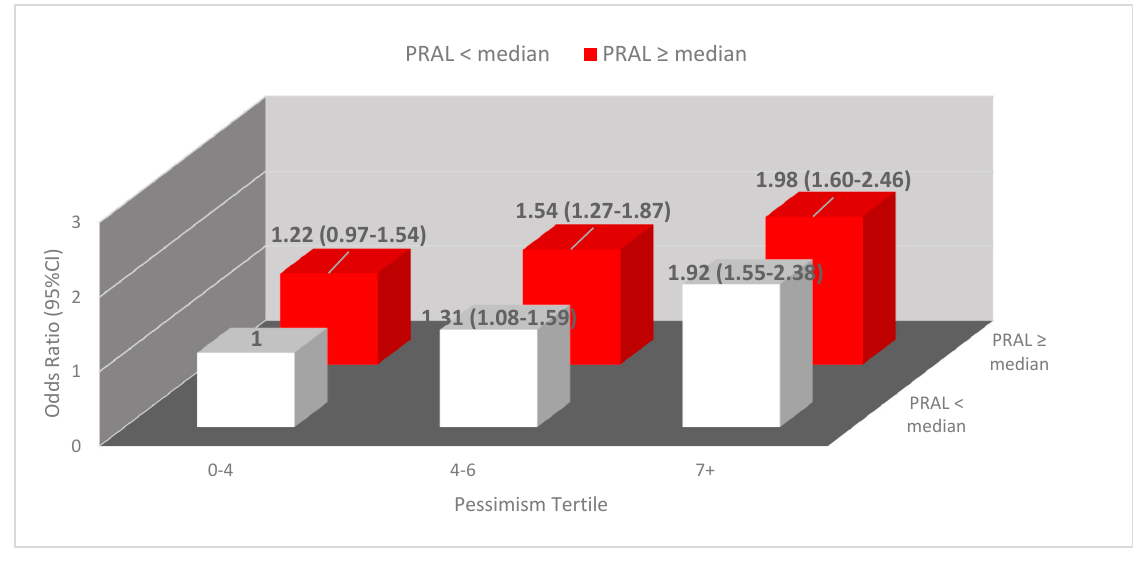
Figure 1. ( A ) Joint association of calorie intake and pessimism with insomnia. Covariates in the multivariable-adjusted model include caffeine quartile, BMI, age, smoking status, status of estrogen receptor and progesterone receptor, baseline co-morbidities, menopausal status, and education. ( B ) Joint association of PRAL and pessimism with insomnia. Covariates in the multivariable-adjusted model include caffeine quartile, BMI, age, smoking pack and years, estrogen receptor and progesterone receptor, co-morbidities, menopausal status, and education. Abbreviations: PRAL potential renal acid load.